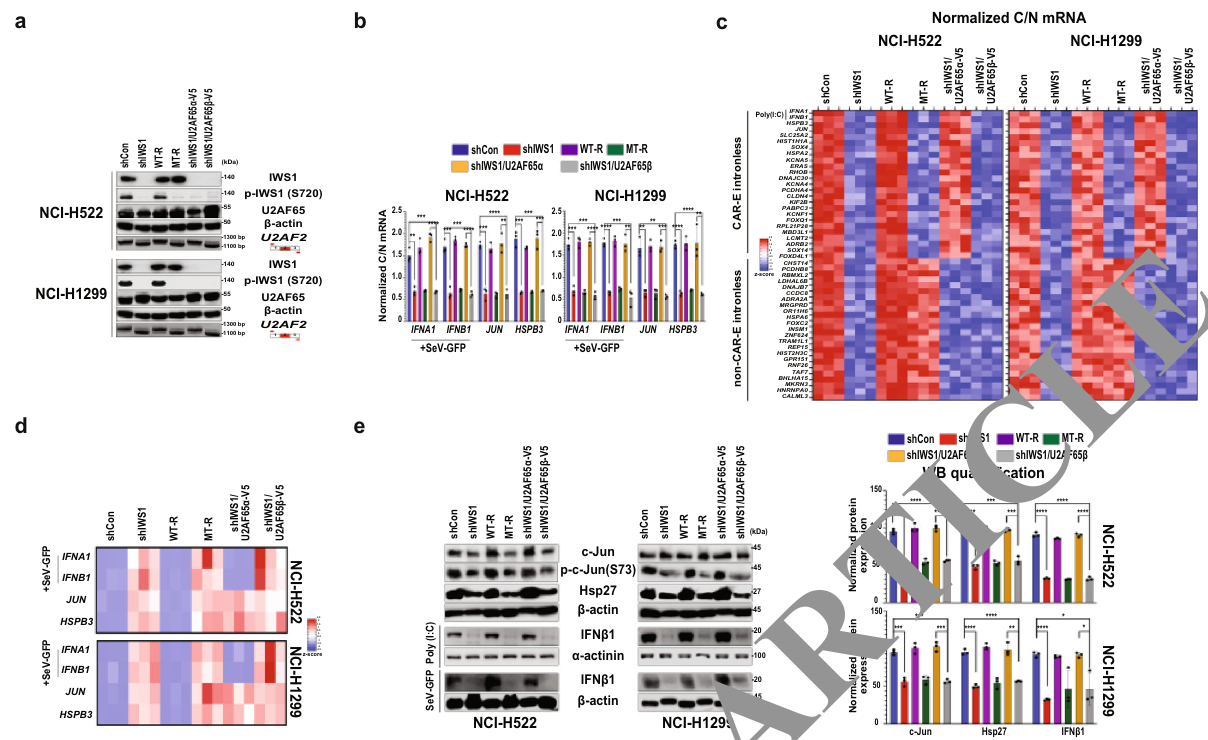
Fig. 1 IWS1 phosphorylation regulates the nucleocytoplasmic transport of mRNAs transcribed from a set of intronless genes, via a process depending on the alternative RNA splicing of U2AF2 . a Western blots of lysates of NCI-H522 and NCI-H1299 cells, transduced with the indicated constructs and probed with anti-IWS1, anti-phosphor-IWS1, anti-U2AF65 and anti- β -actin antibodies. RT-PCR of U2AF2 , using oligonucleotide primers that map in exons 1 and 3 ( fi fth row). b IWS1 phosphorylation regulates the nuclear export of intronless mRNAs . Cells were fractionated into cytoplasmic and nuclear fractions. The abundance of the RNAs of IFNA1, IFNB1, JUN, HSPB3 and GAPDH in each fraction was determined using qRT-PCR and it was normalized relative to the 18S rRNA. Type I IFNs were induced by SeV-GFP infection (MOI 0.5) and cells were harvested at 24 h from the start of the exposure to the virus. Bars show the mean normalized Cytoplasmic/Nuclear RNA ratio ±SD. To validate the fractionation, we measured the Cytoplasmic/Nuclear ratio of the GAPDH RNA (see supplementary Table 4). c Motif analysis of intronless genes identi fi ed sets of CAR-E-positive and CAR-E-negative genes. Using q-RT-PCR, we measured the abundance of the RNAs of 25 CAR-E-positive and 24 CAR-E-negative genes in the cytoplasmic and nuclear RNA fractions described in b. The heatmaps were generated from the z-score of Cytosolic/Nuclear RNA ratios. d Total RNA was harvested from the NCI-H522 and NCI-H1299 cells in a, and b. The expression of the indicated mRNAs was measured by qRT-PCR, and was normalized to 18S rRNA. Heatmaps were generated from the z scores of the abundance of the indicated RNAs. Type I IFNs were induced by infection with SeV-GFP. e (Left panel) Western blots of lysates of the NCI-H522 and NCI- H1299 cells in ( a , b ) were probed with the indicated antibodies. Type I IFNs were induced by infection with SeV-GFP or by treatment with Poly (I:C) {5 μ g/ mL for 6 h (NCI-H522) or 12 h (NCI-H1299)}. (Right panel) Quanti fi cation of the relative abundance of the indicated proteins in the experiment on the left. Bars show relative expression normalized to loading control±SD. All experiments in this fi gure were done in triplicate, on three biological replicates. n.s: non-signi fi cant * p < 0.05, ** p < 0.01, *** p < 0.001, **** p < 0.0001 (one-side unpaired